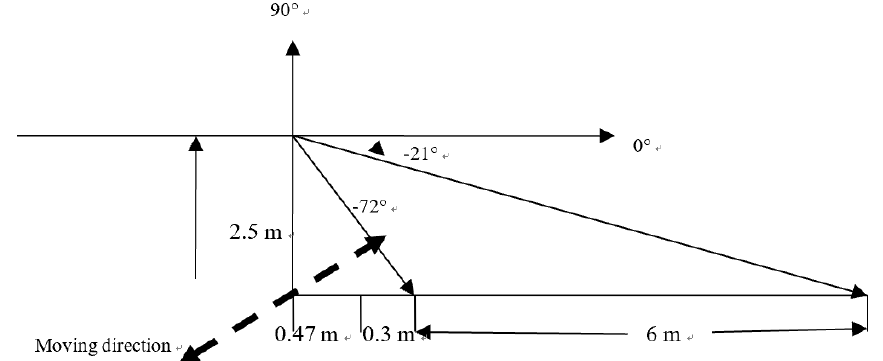
Figure 4. Sketch of the combined scanning mode of the microwave radiometer.